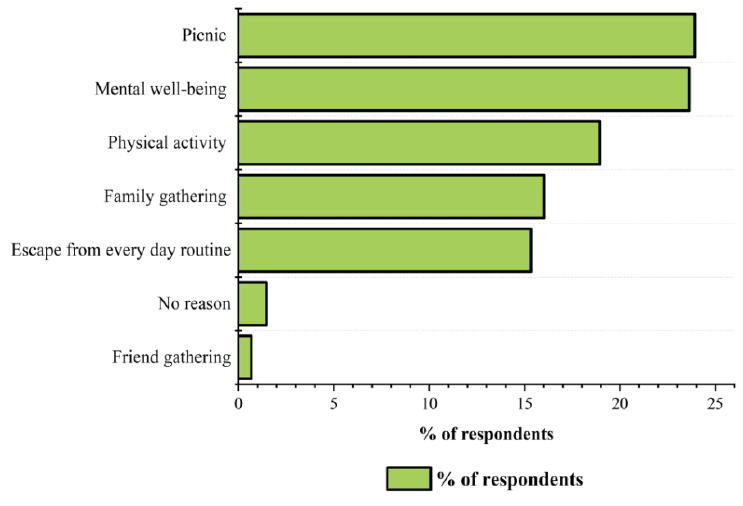
Figure 5. Preference of green spaces (GSs) by the respondents.